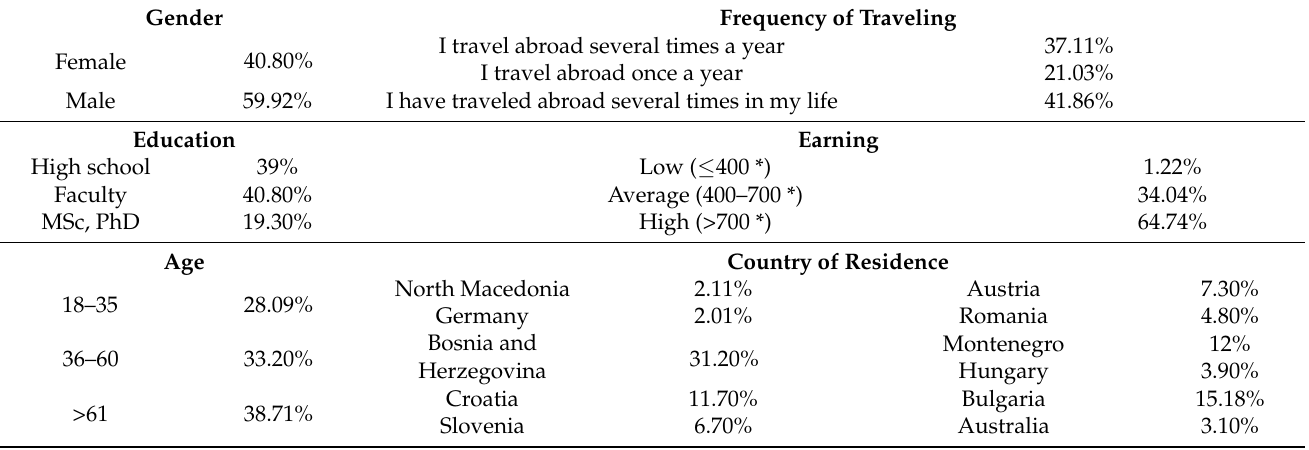
Table 1. Sociodemographic description of the